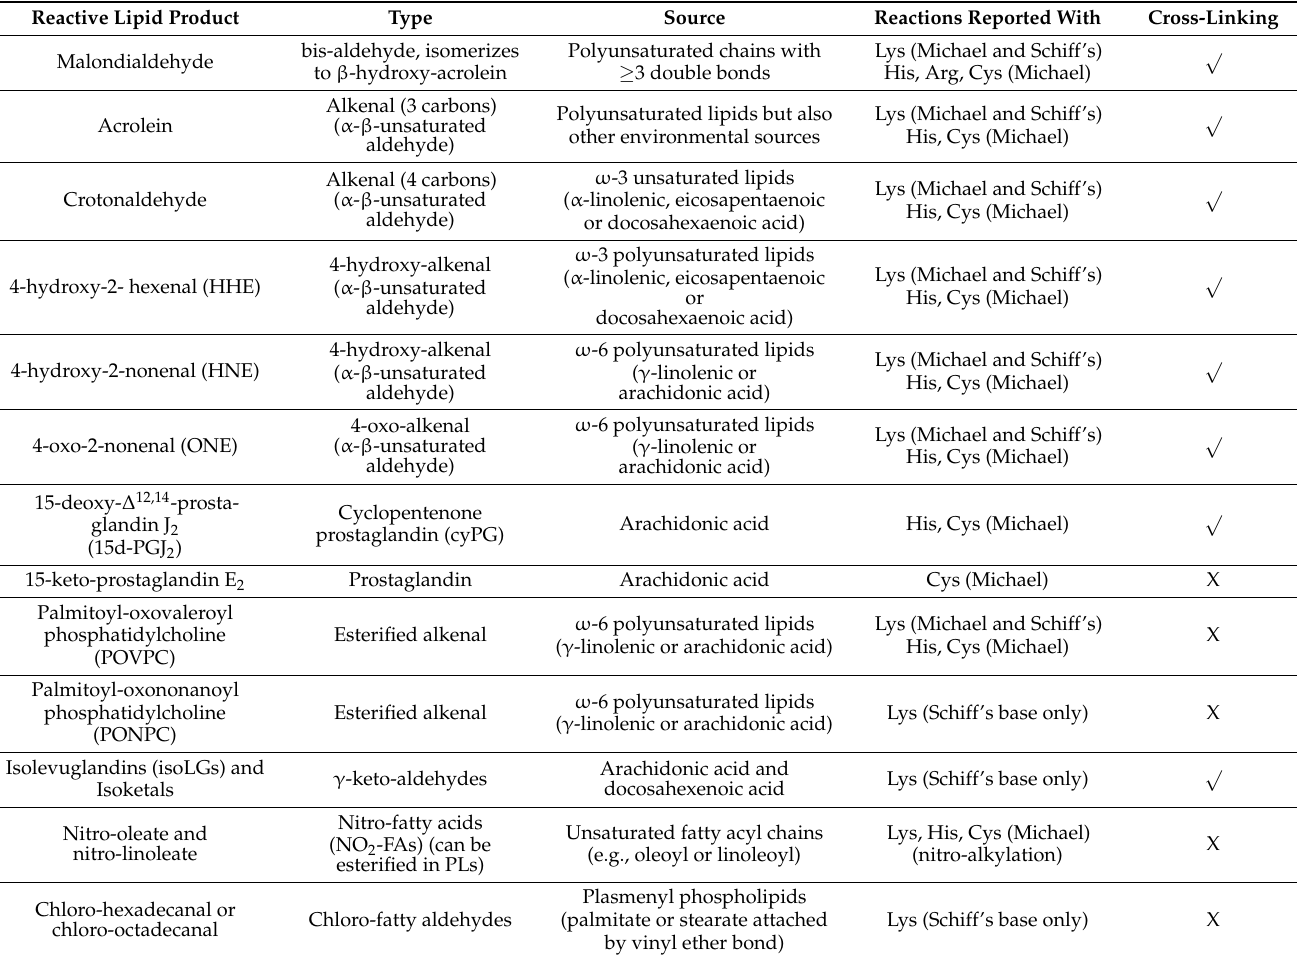
Table 1. Examples of electrophilic lipid products that can cause